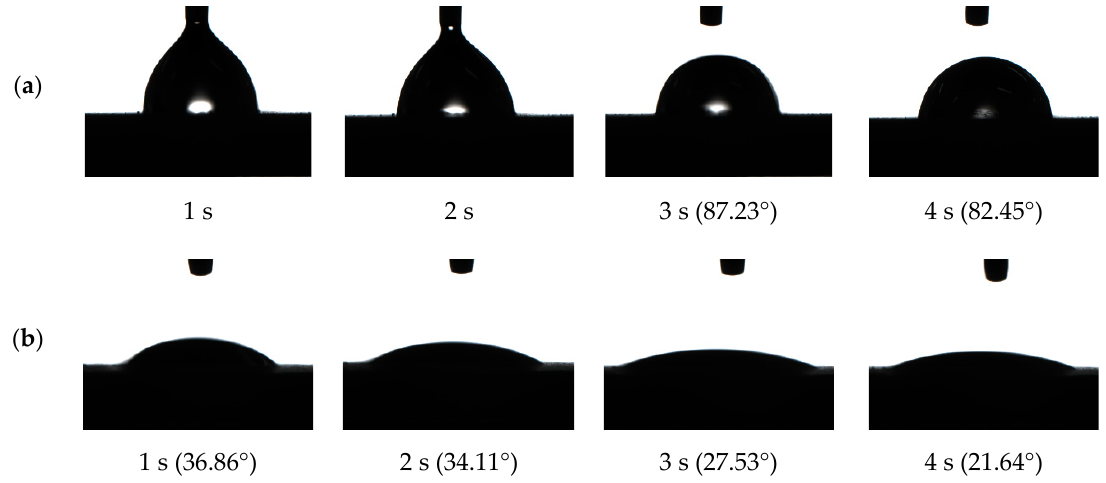
Figure 13. The we tt ing process and contact angle of the di ff erent solutions to coal dust: ( a ) water; Figure 13. The wetting process and contact angle of the different solutions to coal dust: ( a ) water; ( b ) 0.02% AEO-9. ( b ) 0.02% AEO-9.